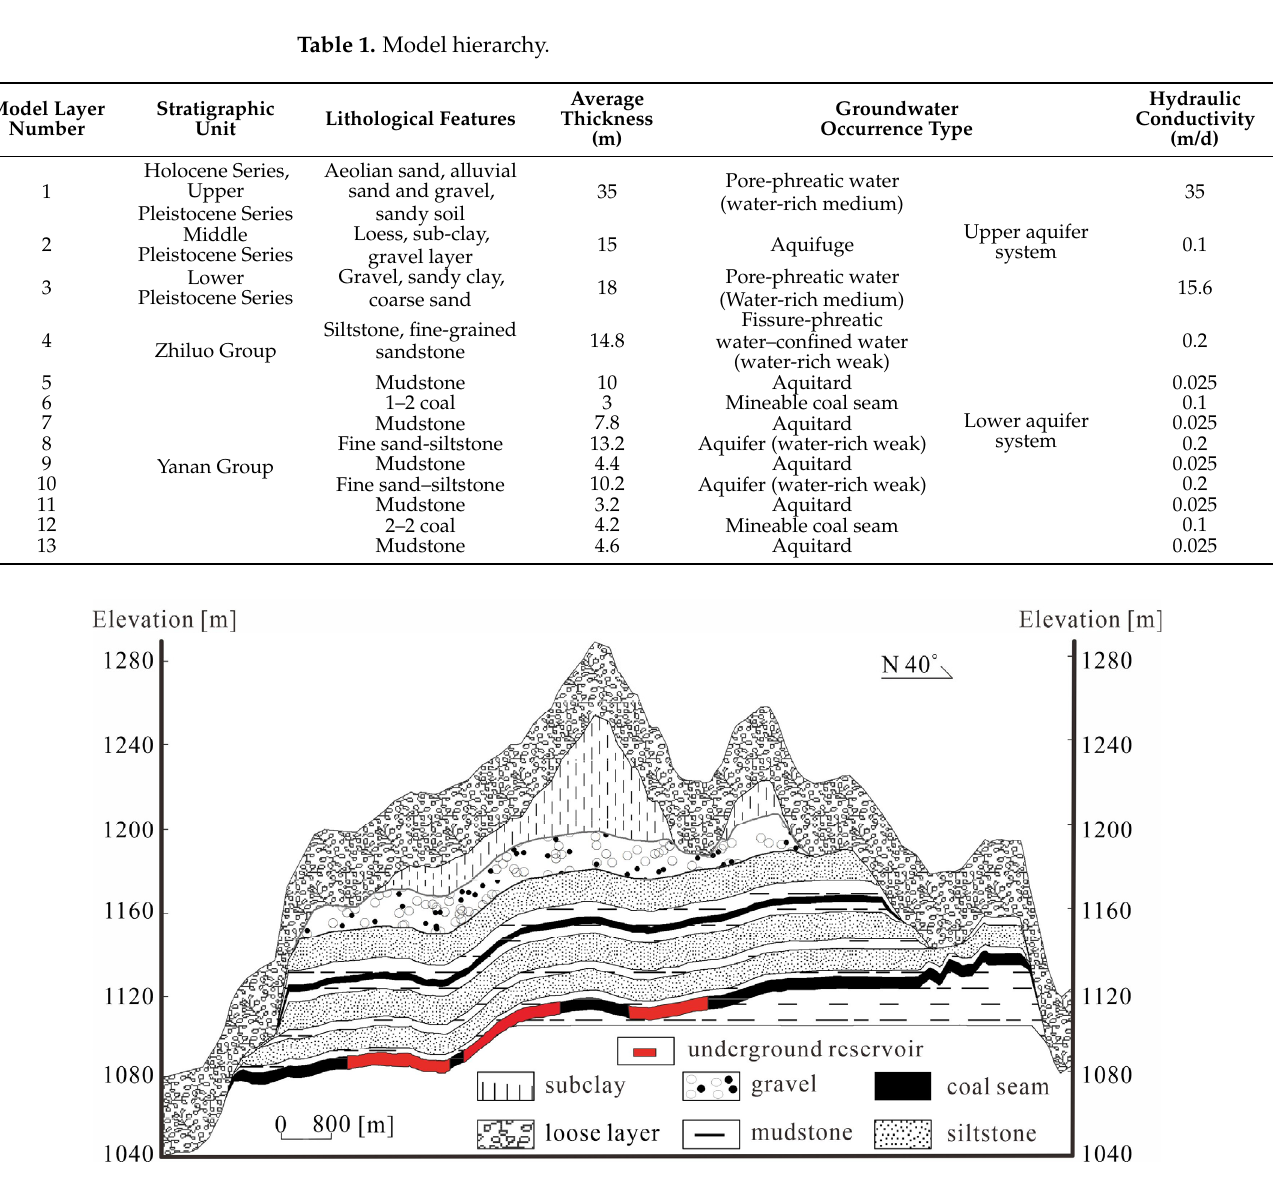
4 of 20 Table 1. Model hierarchy. Model Layer Number